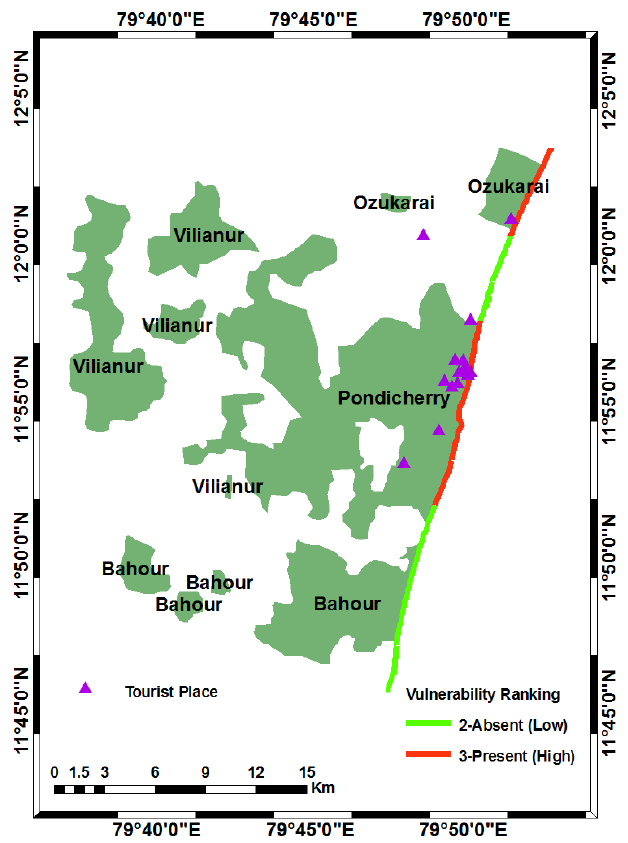
Fig. 10. Vulnerability ranking map of distribution of tourist areas.